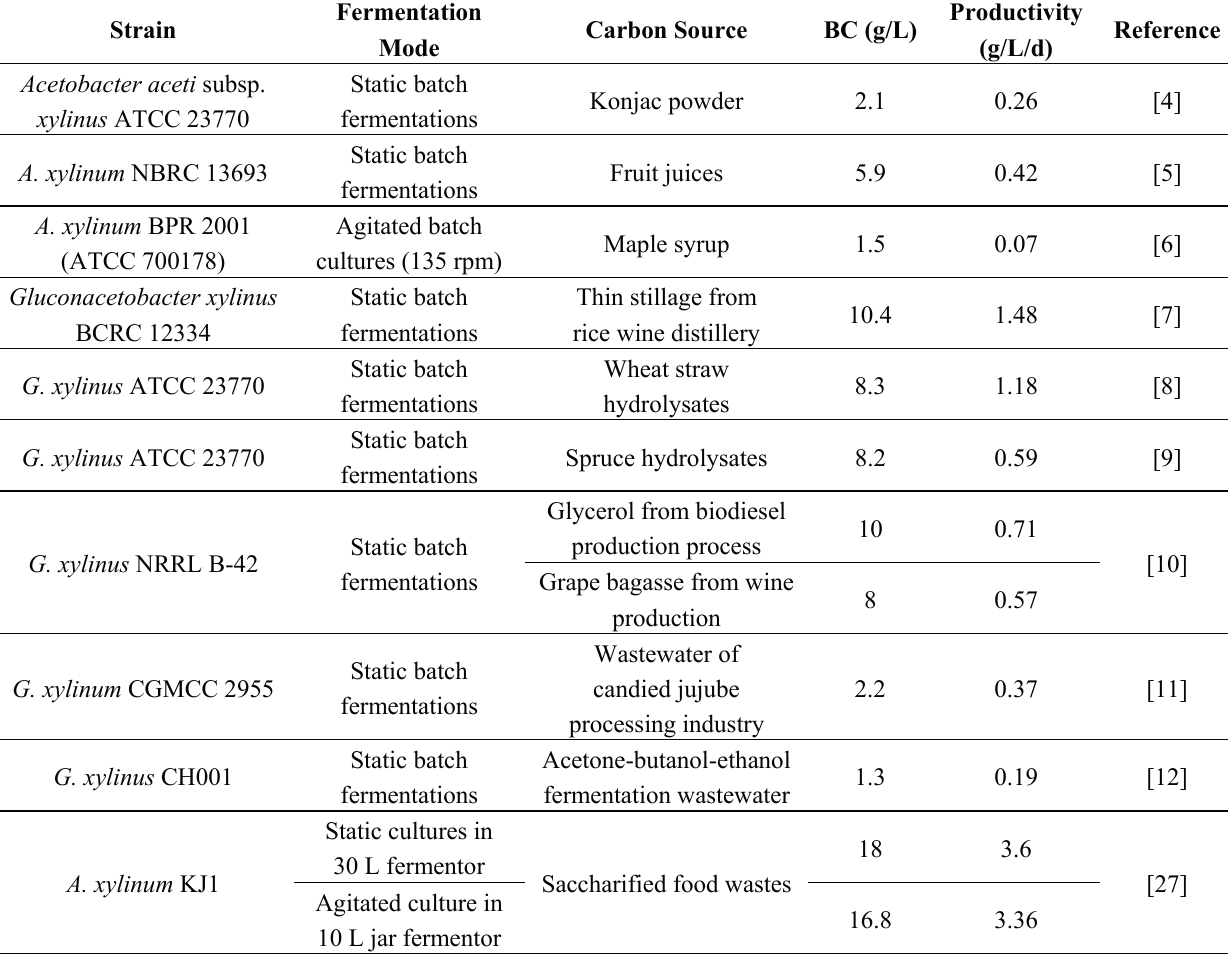
Productivity Reference (g/L/d)